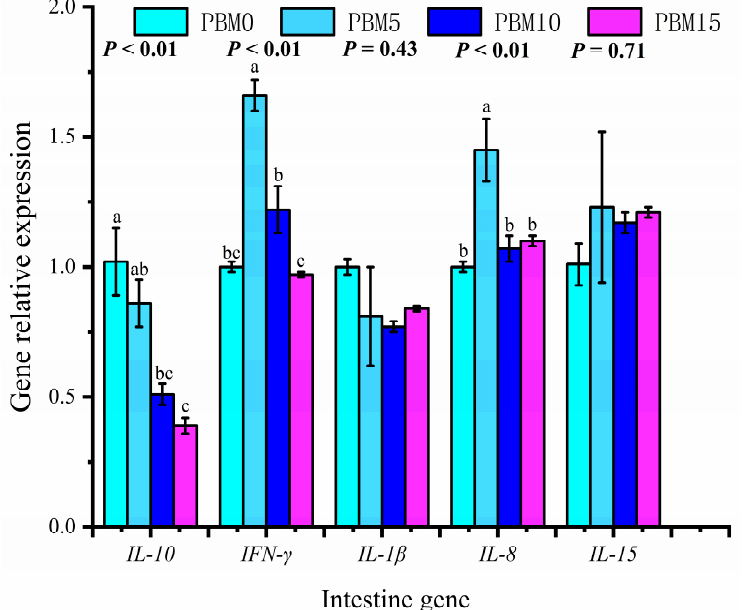
Figure 6. Effects of dietary replacement of fish meal with poultry by − product meal on the intestinal gene expression of Chinese soft − shelled turtle. Error bars was represented the mean ± standard error (n = 6). Different letters indicated significant differences between groups ( p < 0.05).